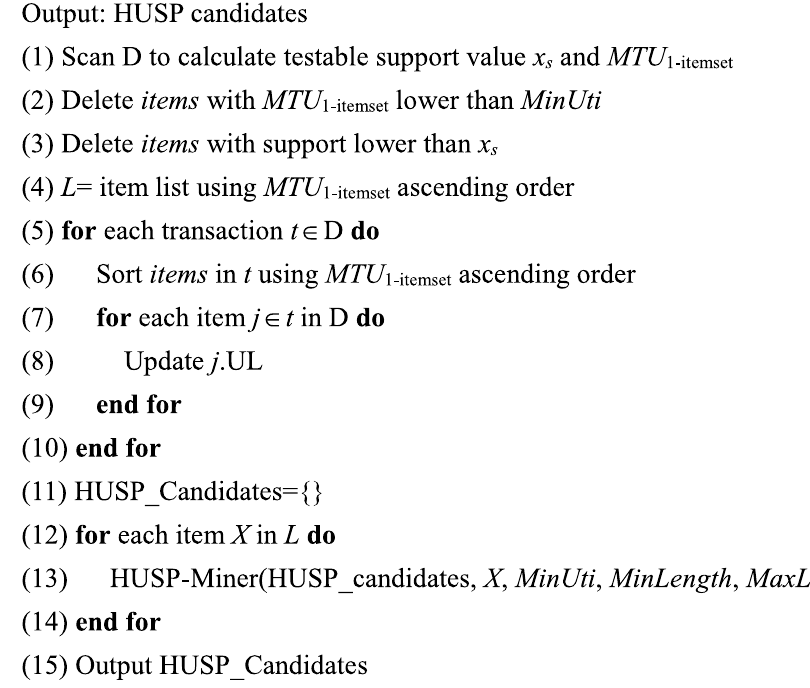
Fig. 1 Procedure of HUSP-